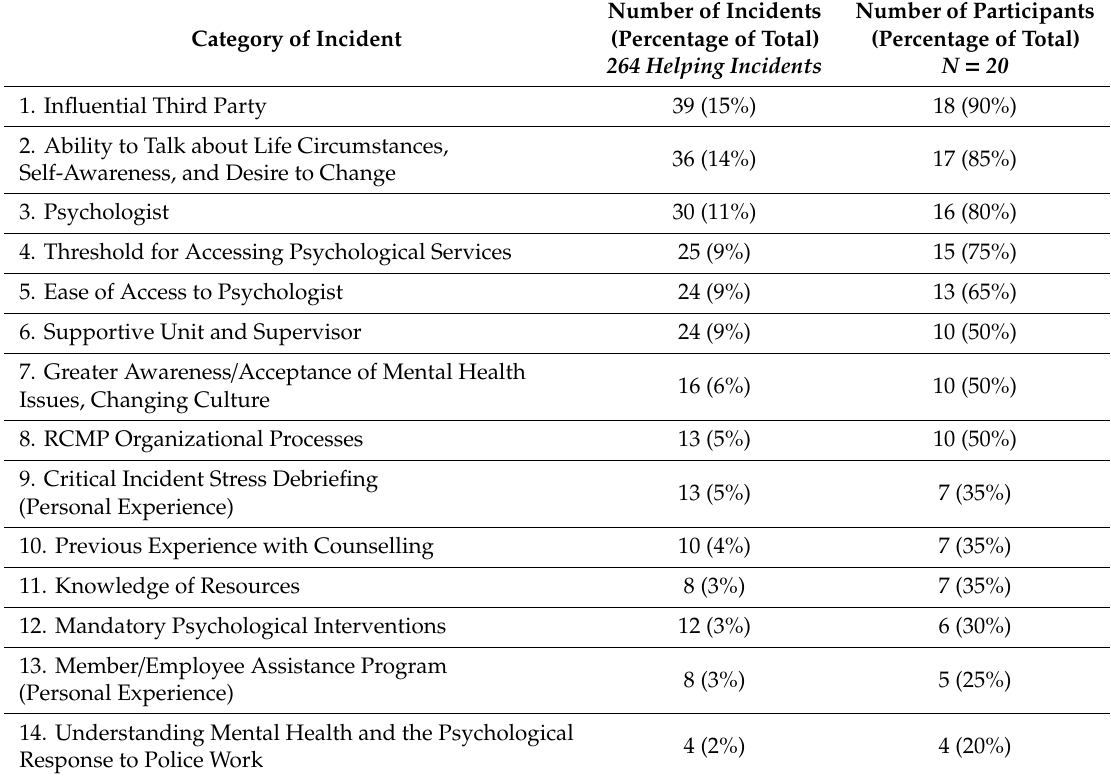
Table 1. Incidents That Helped the Decision to Access Psychological Services.